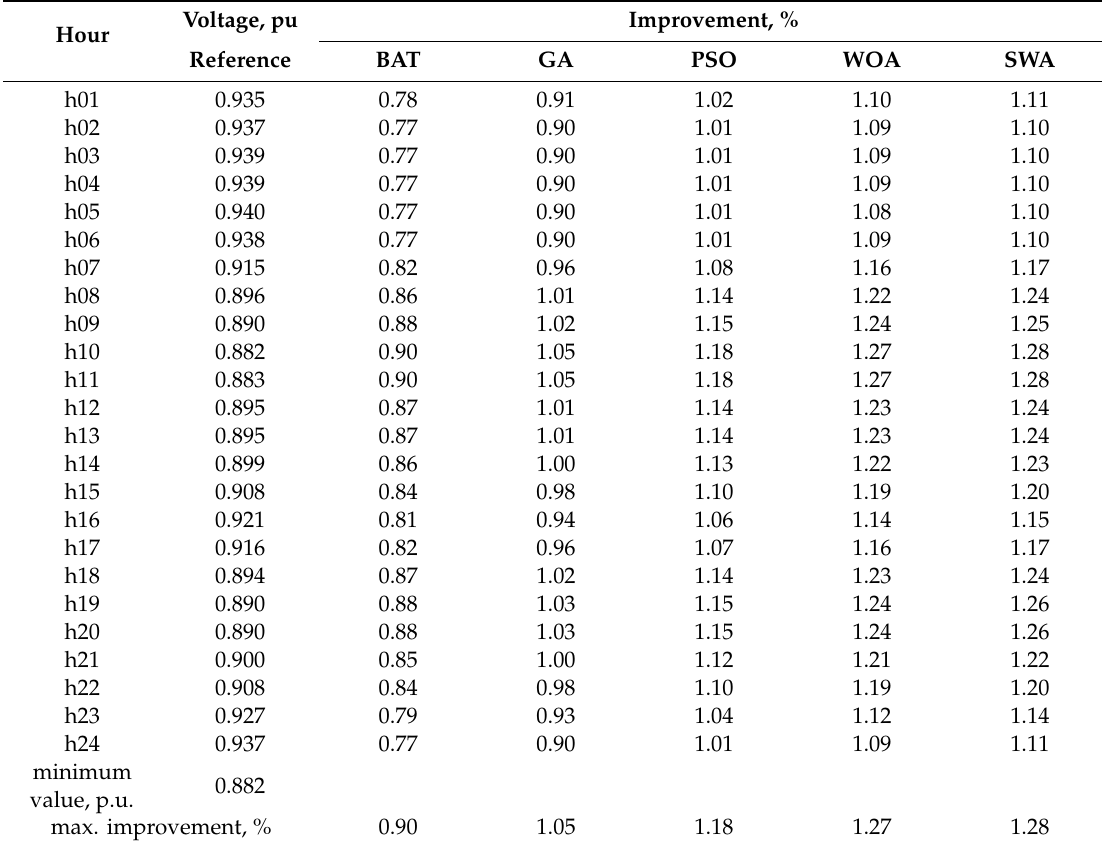
Table 11. Hourly reference voltage values for bus 33 and percent improvements after compensation, the IEEE 33-bus test